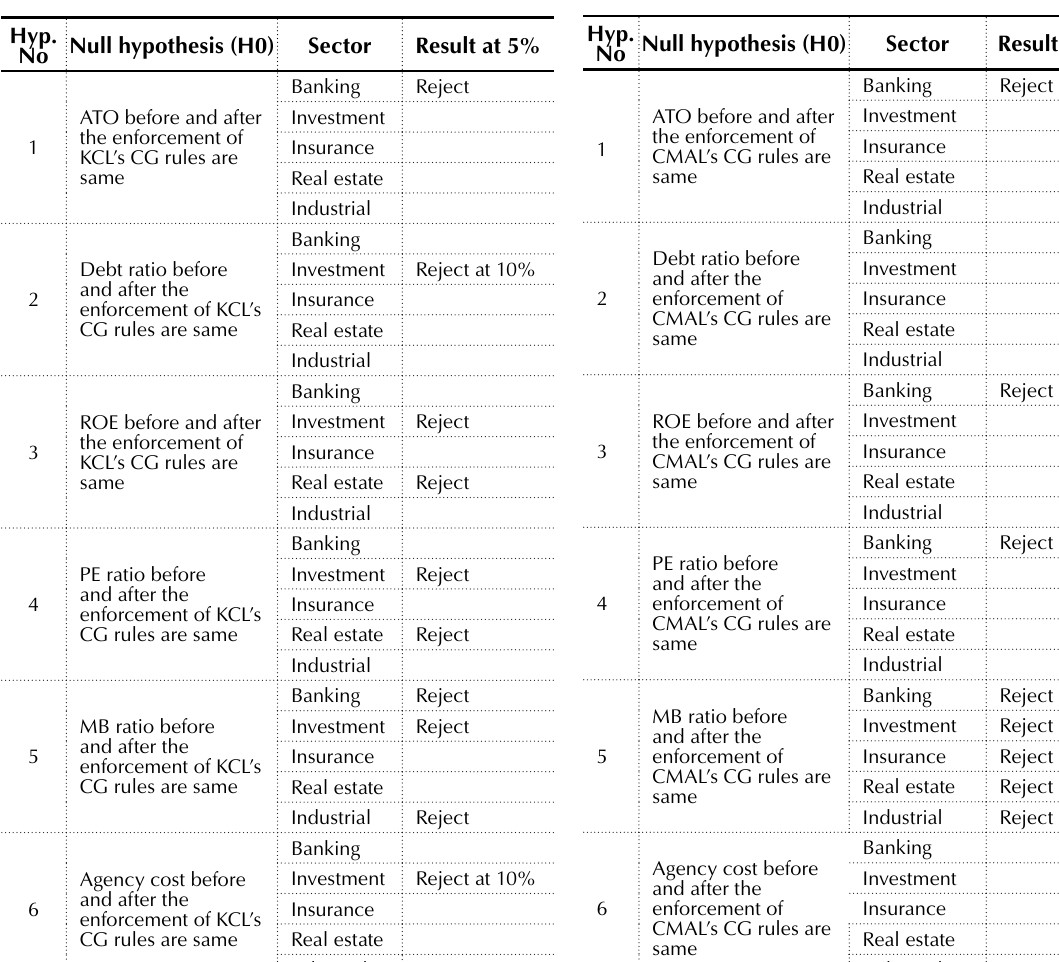
Table 5. Summary of hypotheses testing results based on